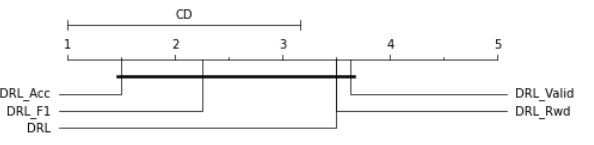
Figure 3. A critical difference diagram for 5 different DRL models on different datasets of telemetry water level data.